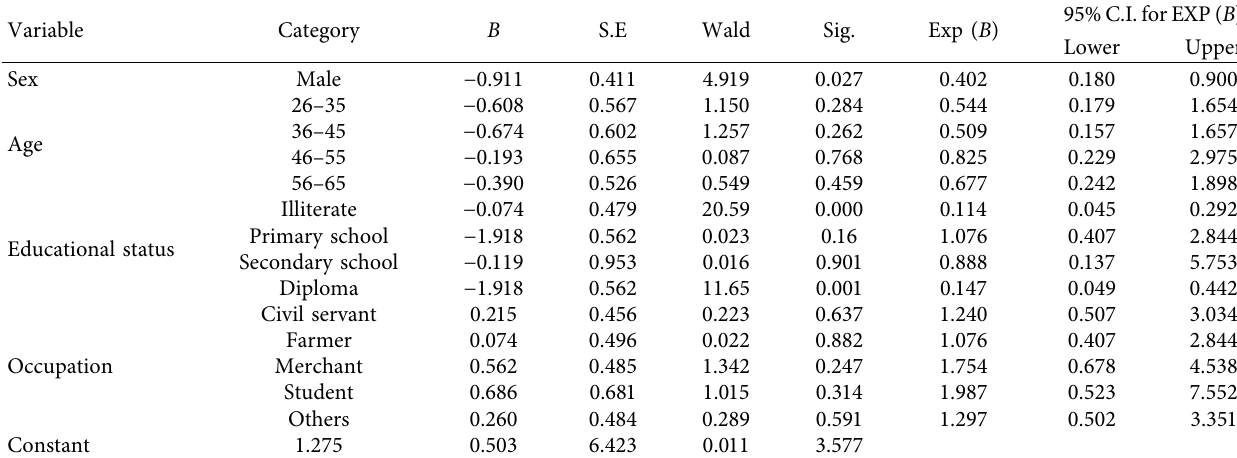
Table 9: Multivariable binary logistic regression analysis of practicable factors for the elimination of onchocerciasis from Gesha town,